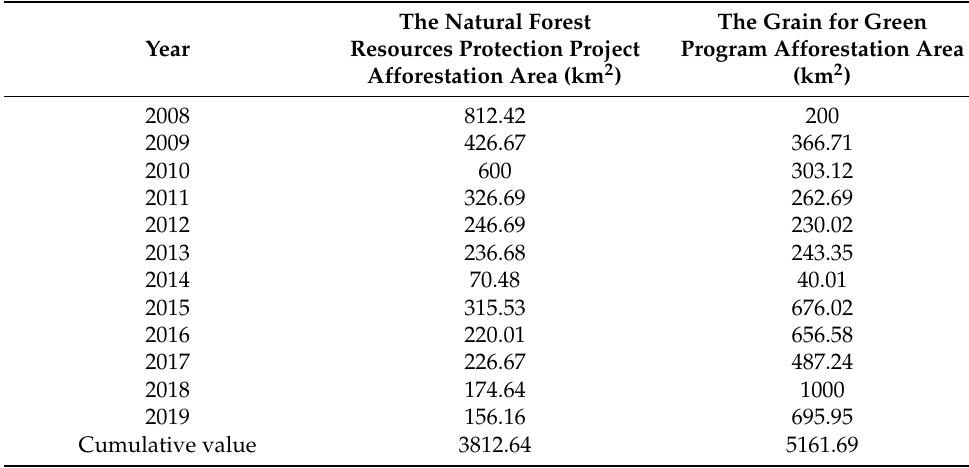
Table 9. Area of afforestation for two key ecological projects related to forestry.